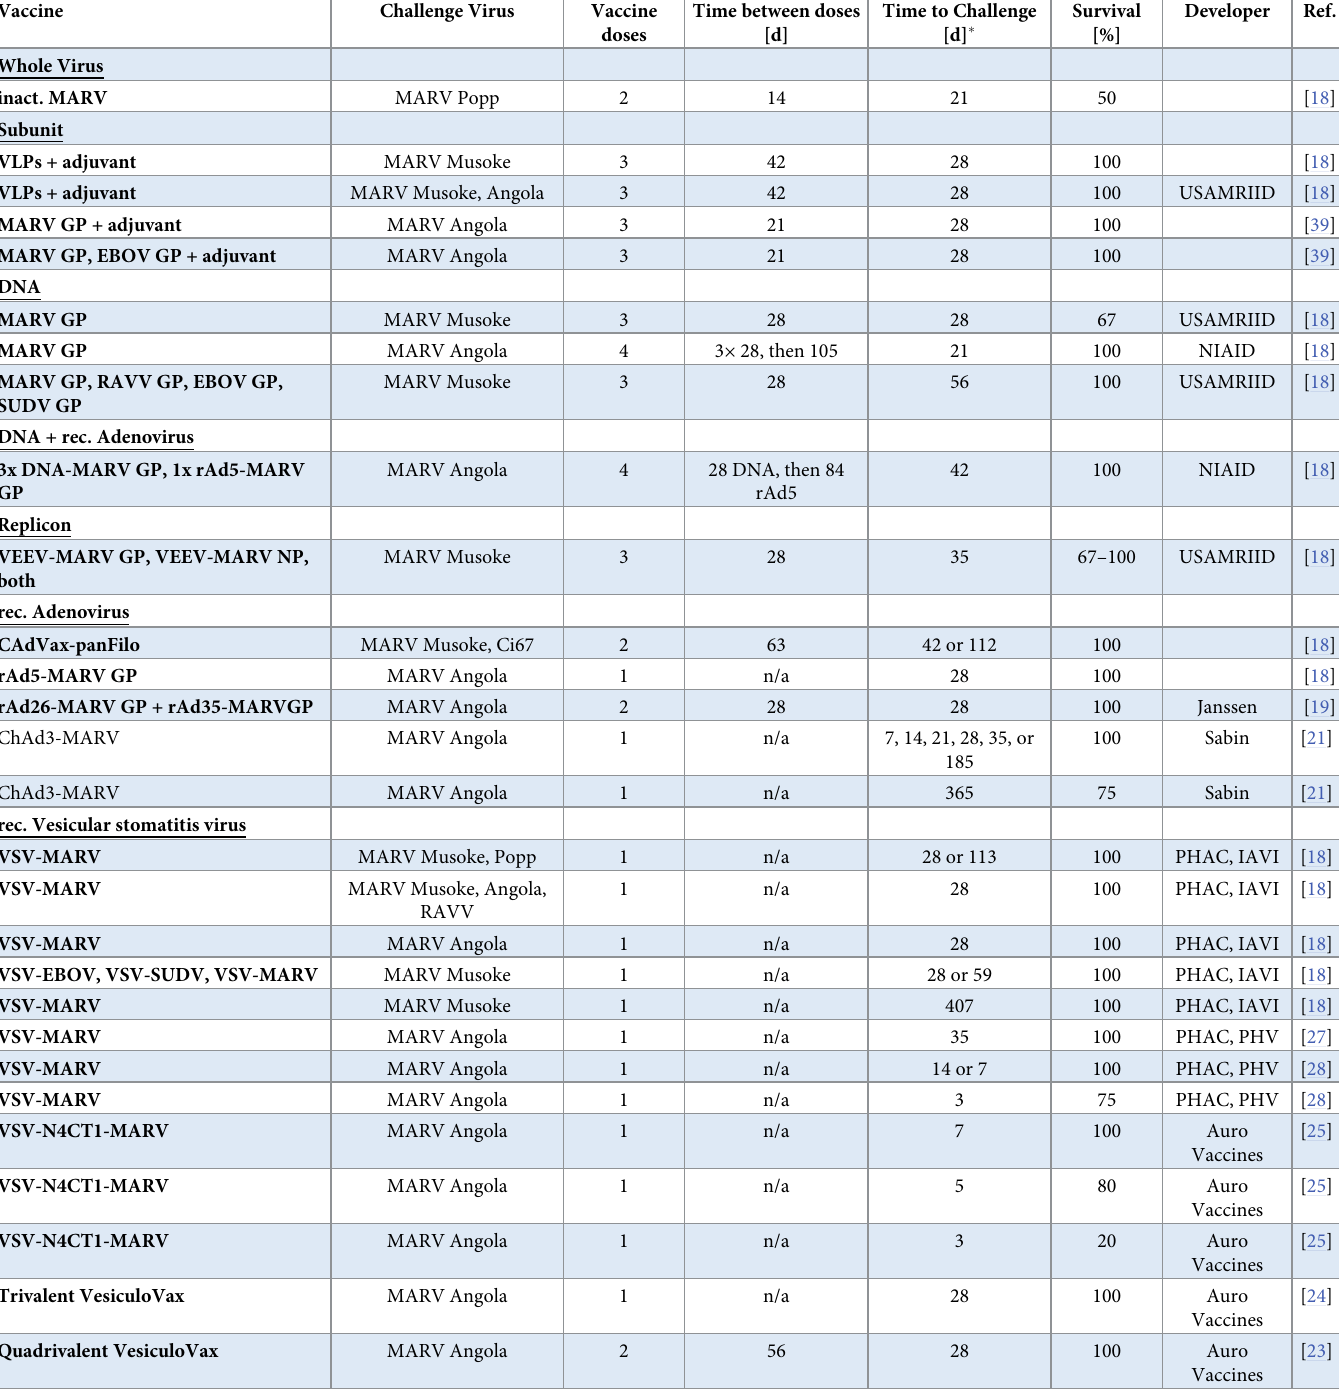
Table 1. MARV vaccines with protective efficacy in the preclinical NHP